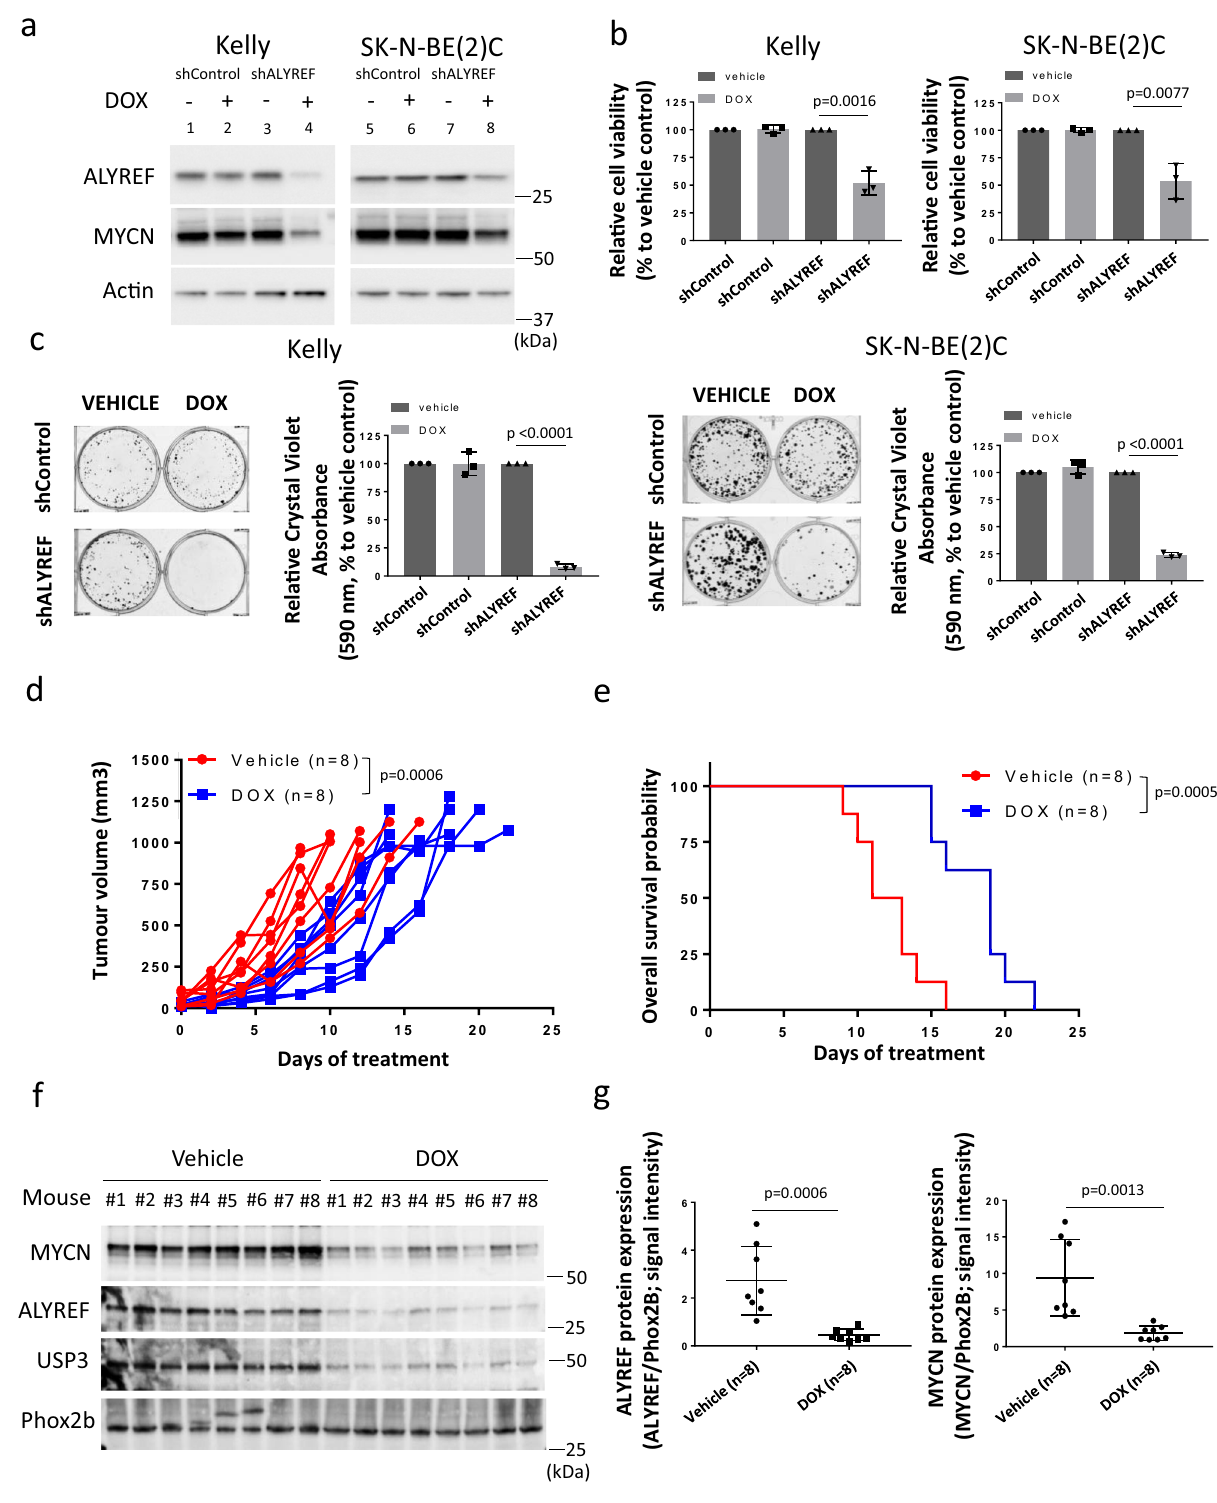
2-Microglobulin (B2M). Primer sequences (Supplementary Table 5) were obtained from Integrated DNA Technologies (NSW, Australia). Biotechnology and rabbit from Cell Signaling) and A/G PLUS agarose beads (Santa Cruz Biotechnology) at 4°C overnight. After three washes with the lysis buffer, the Immunoprecipitation . For endogenous MYCN or ALYREF immunoprecipitation bound proteins were eluted by boiling with SDS sample buffer. Bound proteins assays, cells were lysed in cold NP40 buffer (Sigma) supplemented with protease were resolved by SDS-PAGE. inhibitor (Sigma). For endogenous USP3 immunoprecipitation assays, cells were For immunoprecipitation of ectopically expressed Flag and HA-tagged proteins, lysed in cold BC100 buffer (Sigma) supplemented with protease inhibitor (Sigma). HEK293T human embryonic cells were transiently co-transfected with an 5% of the cell extract was saved as the input, and the rest (750 μ g total protein) was HA-MYCN-expression pcDNA3.1 construct, together with an empty vector or incubated with either 10 μ g MYCN-speci fi c antibody (Merck Millipore, VIC, NATURE COMMUNICATIONS| (2021) 12:1881